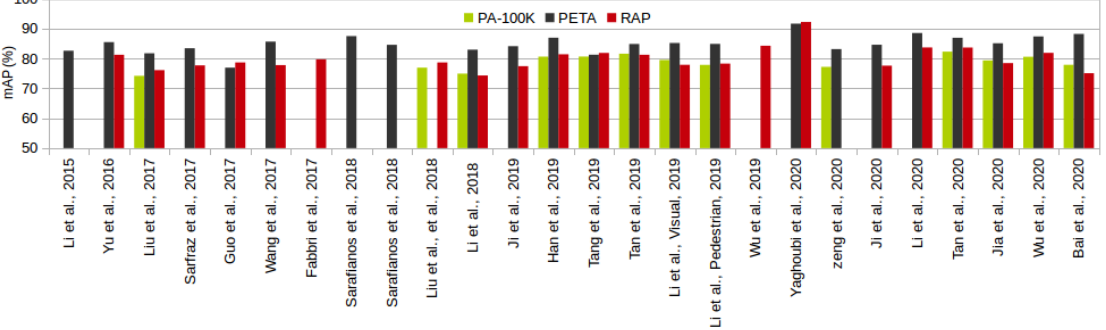
Figure 6. State-of-the-art mAP results on three well-known PAR